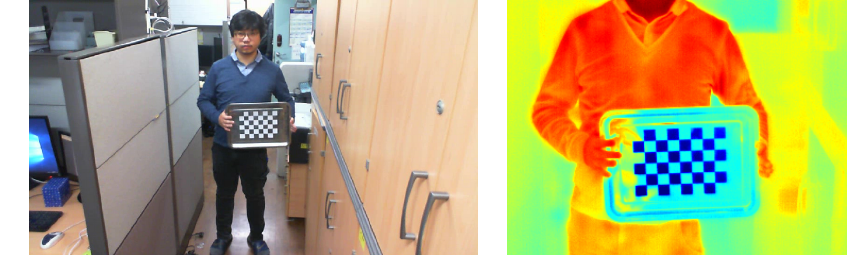
Figure 1. Examples of visual and thermal images used for calibration.